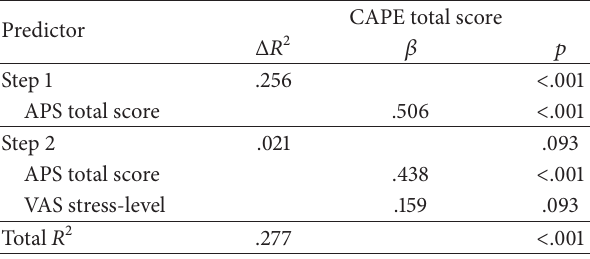
Table 2: Multiple regression analyses predicting psychotic symp- toms from arousal predisposition and general levels of